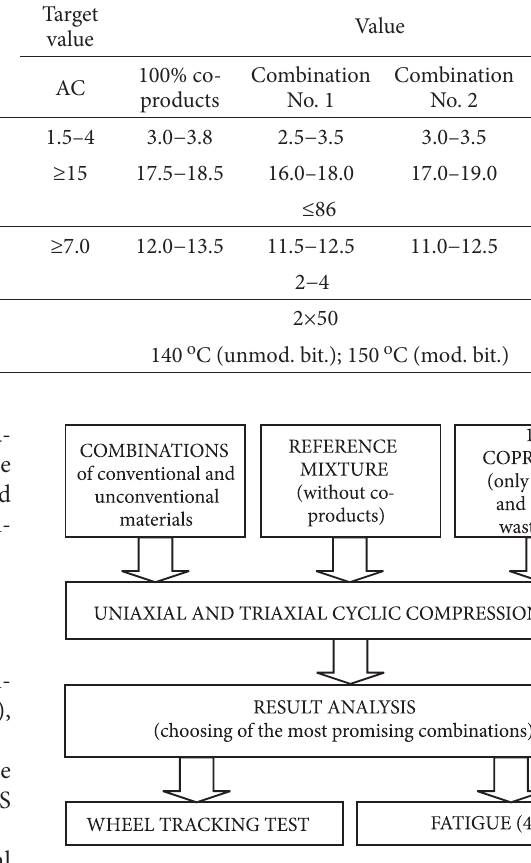
fig. 2. Performance evaluation